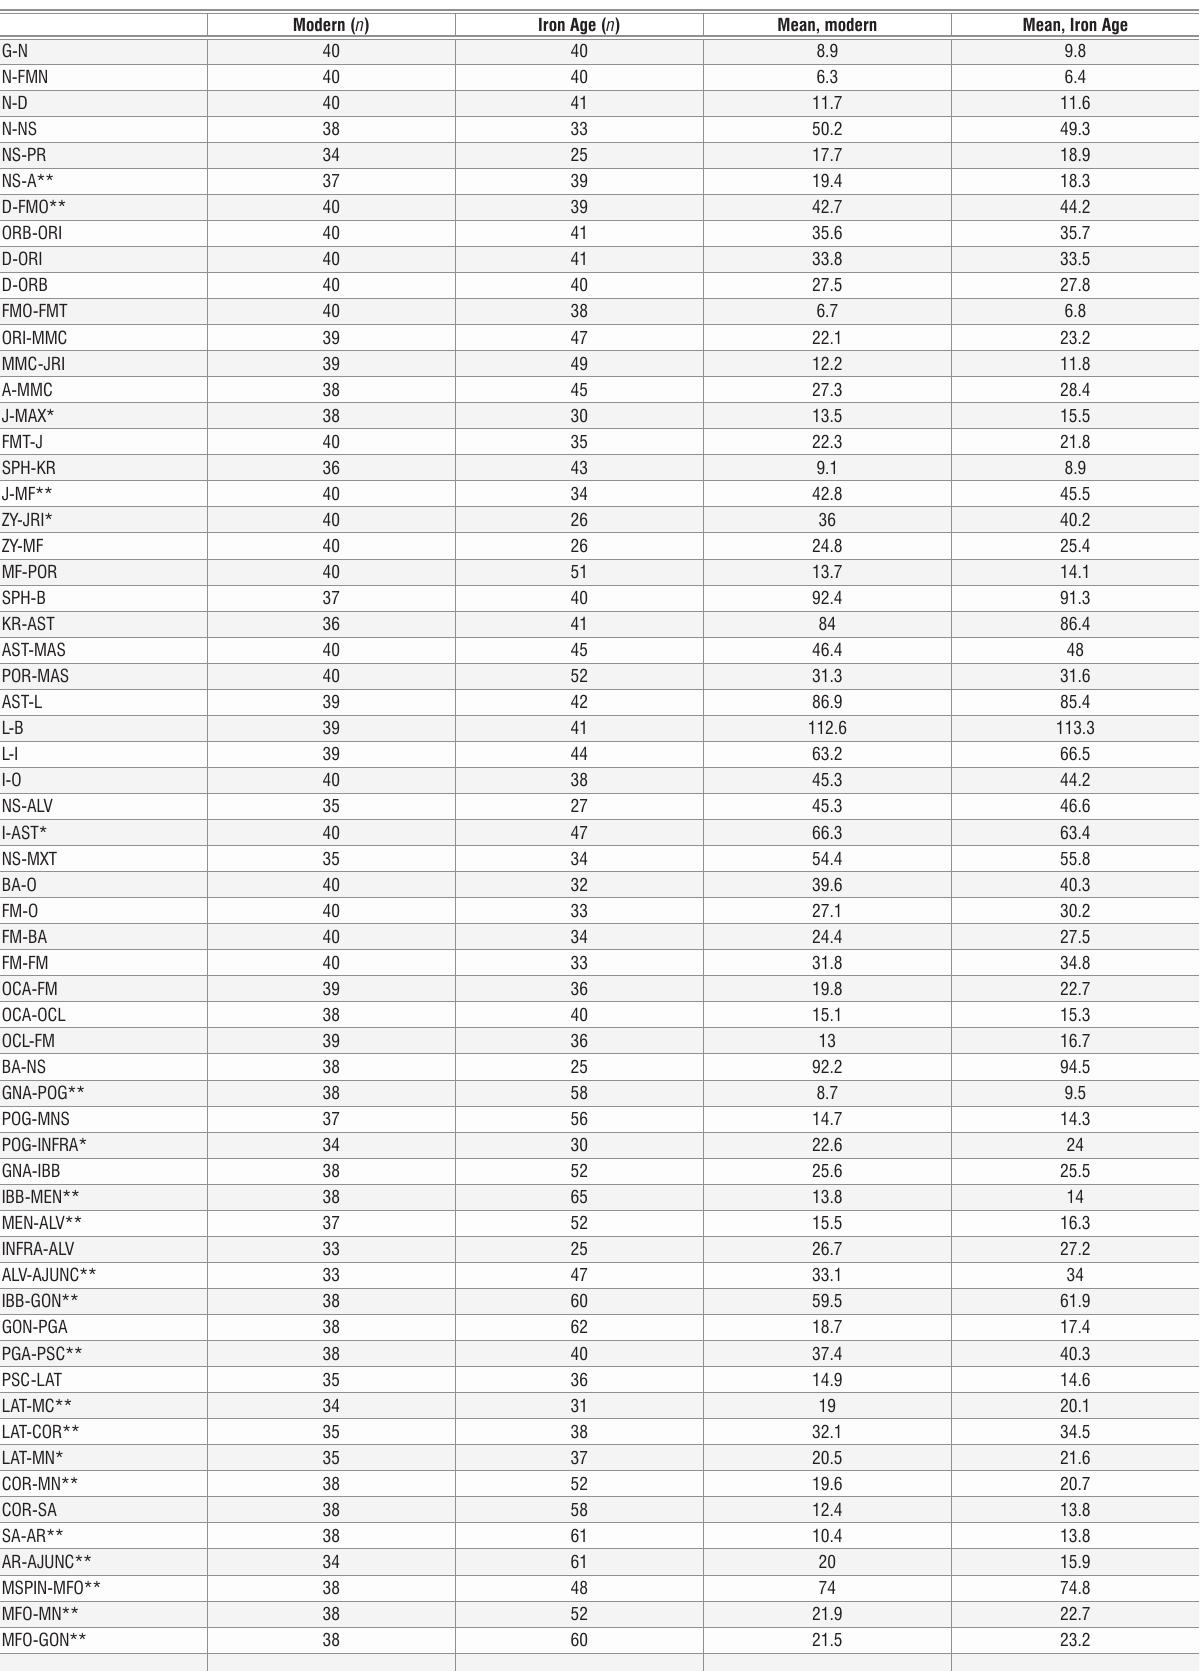
Table 6: Craniomandibular measurements, associated sample sizes and means (in mm) of the modern and Iron Age